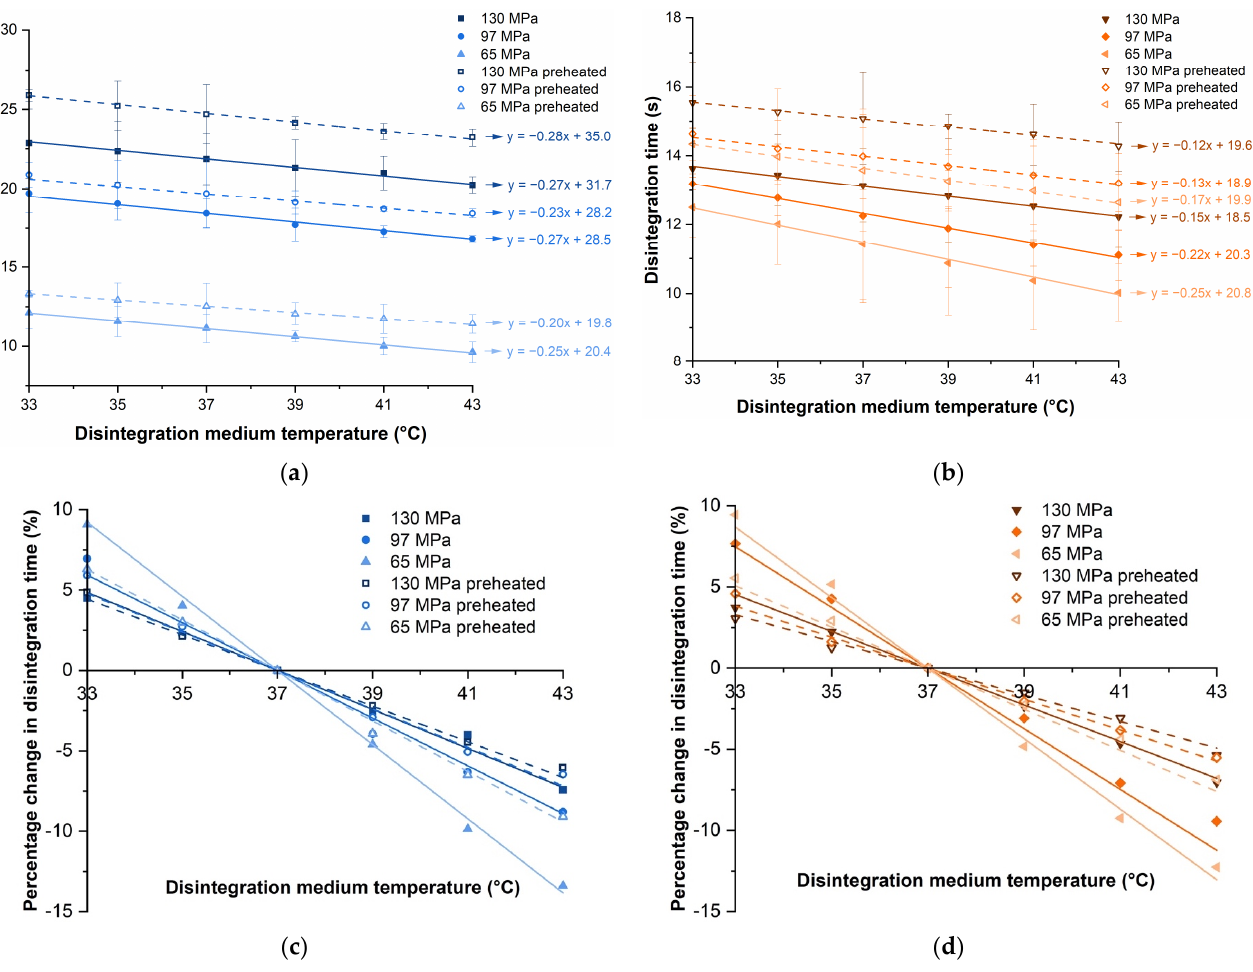
Figure 5. Plots of disintegration time against disintegration medium temperature for tablets containing ( a ) SSG and ( b ) XPVP, with or without preheating, produced at different compaction pressures; plots of percentage change in disintegration time against disintegration medium temperature for tablets consisting of ( c ) SSG and ( d ) XPVP, with and without preheating, produced at different compaction pressures. Note: All trend lines drawn are best fit lines.